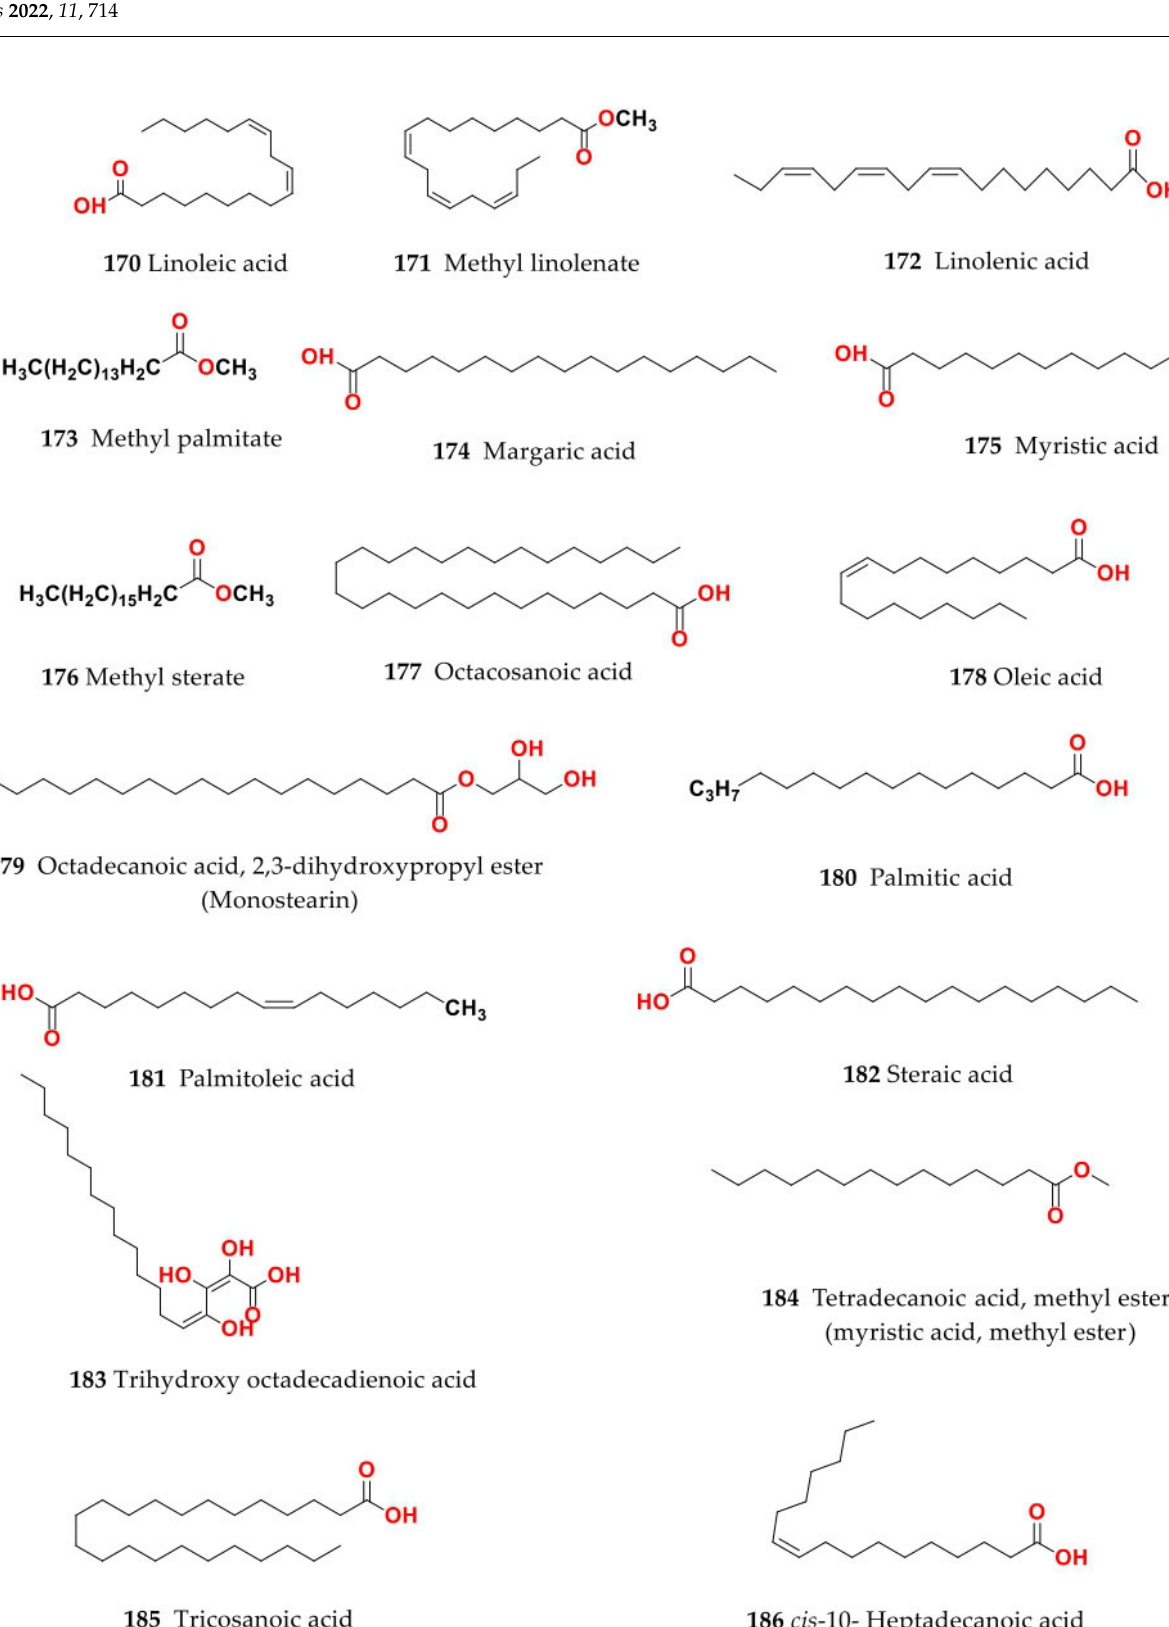
Figure 14. Chemical structure of fatty acids ( 170 – 186 ) isolated from genus Salsola.